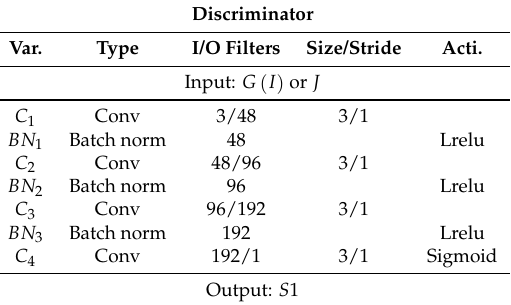
Table 3. Details of